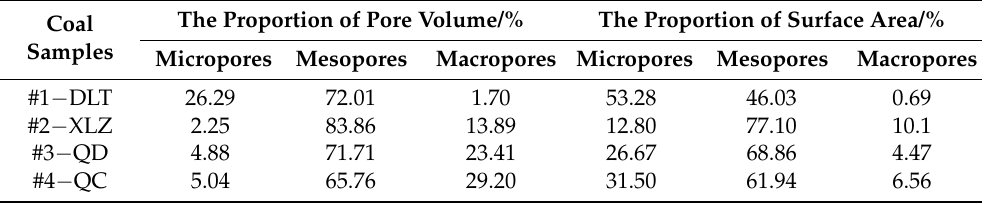
Table 4. Calculation results of the proportion of the pore volume and specific surface area of micropores, mesopores, and macropores to the whole adsorption